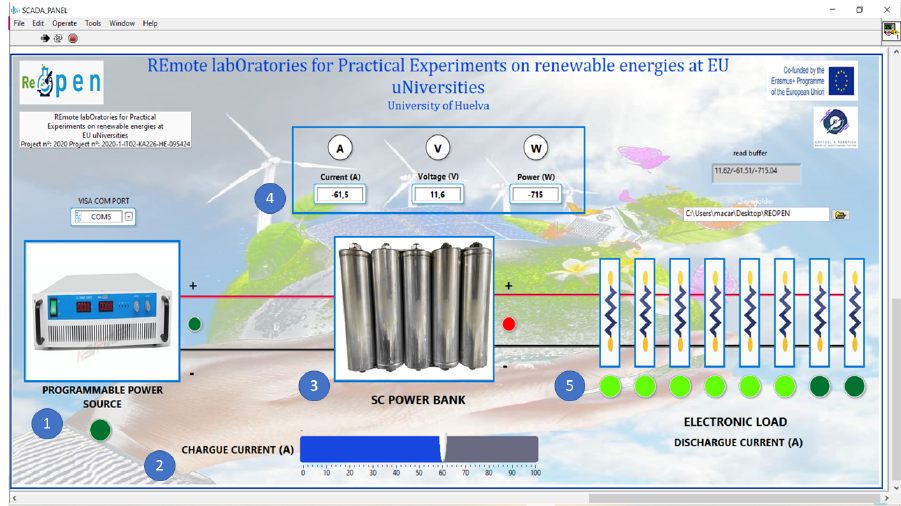
Figure 14. User interface of the remote laboratory of supercapacitor power bank: discharging pro- cess.